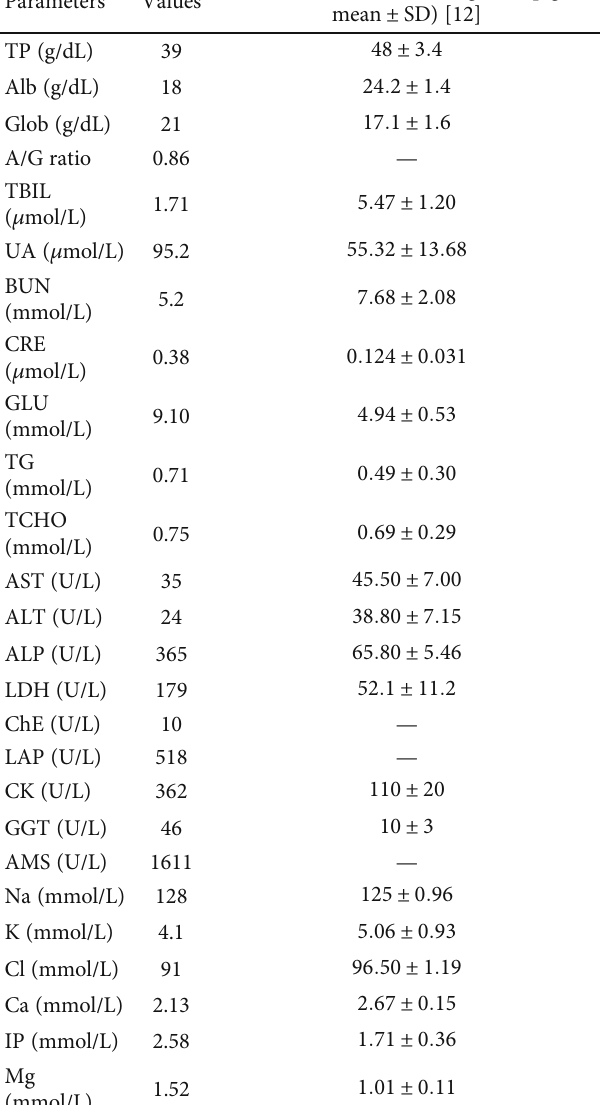
Table 1: Hematological pro fi les. Table 2: Serum biochemical pro fi les.